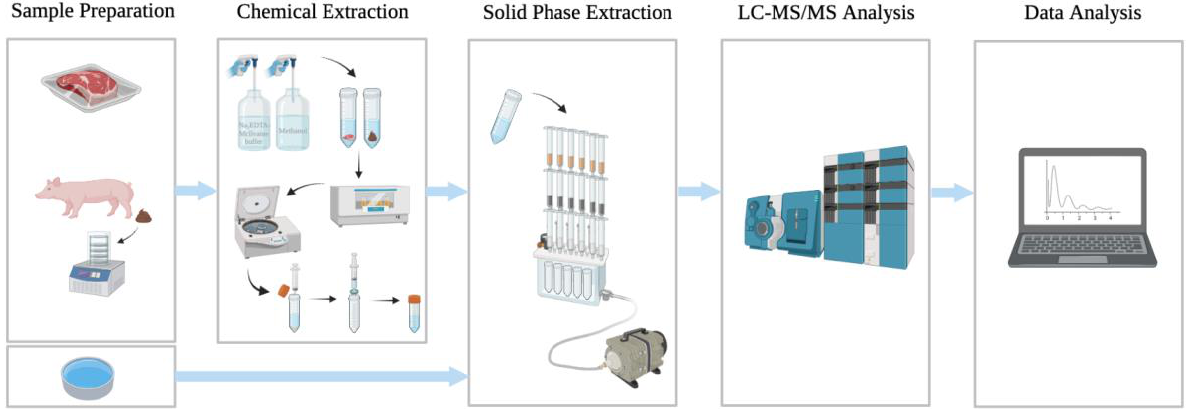
Figure 1. Flowchart showing the key steps in antibiotic residue testing. The figure was created with